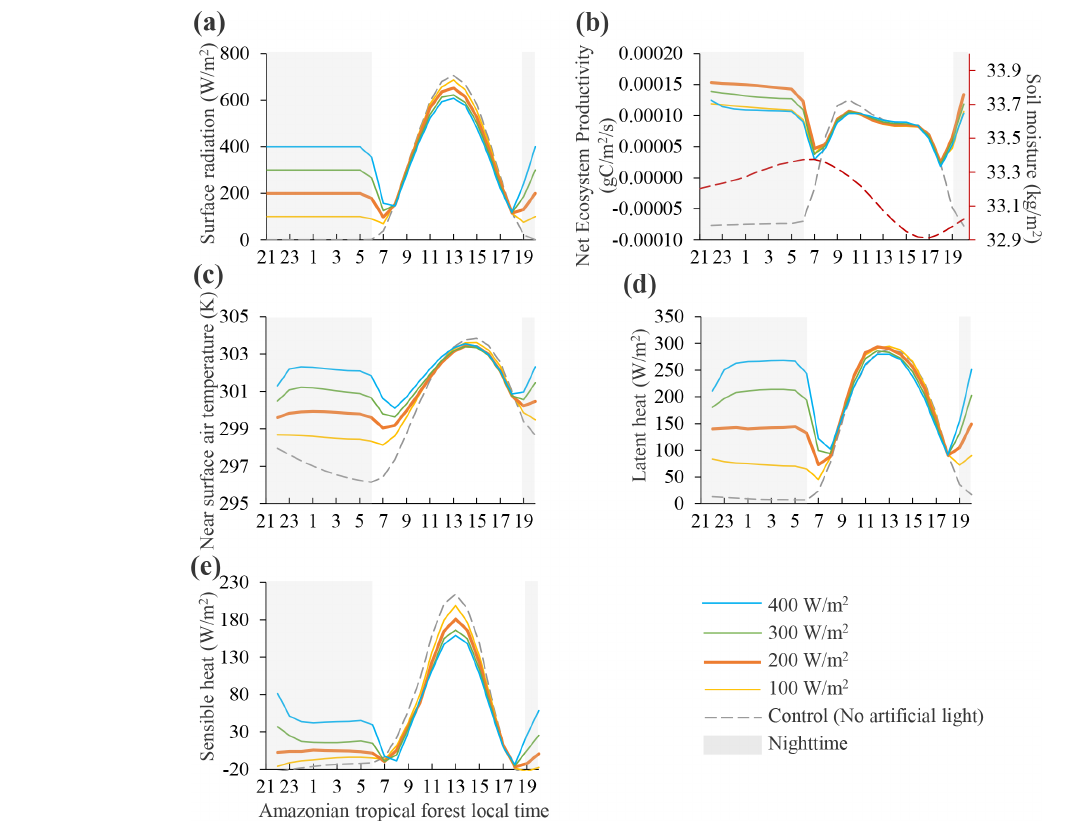
Figure 1. Amazonian tropical forest responses for 24h since the start of the nighttime lighting experiment at 12:00UTC on 1 January 2015 under various nighttime lighting power. Panel (a) refers to surface downward shortwave radiation. Nighttime NEP (b) reached the peak at 200Wm − 2 , suggesting that 200Wm − 2 is optimal in terms of activating additional